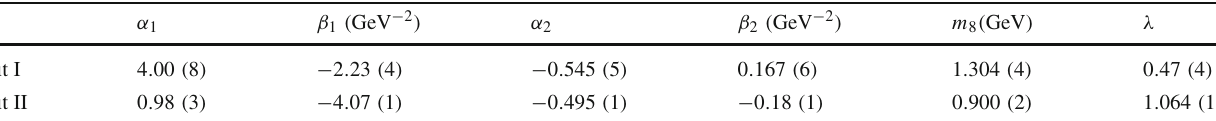
Table 2 Parameters of the two-channel T -matrix in the two fits